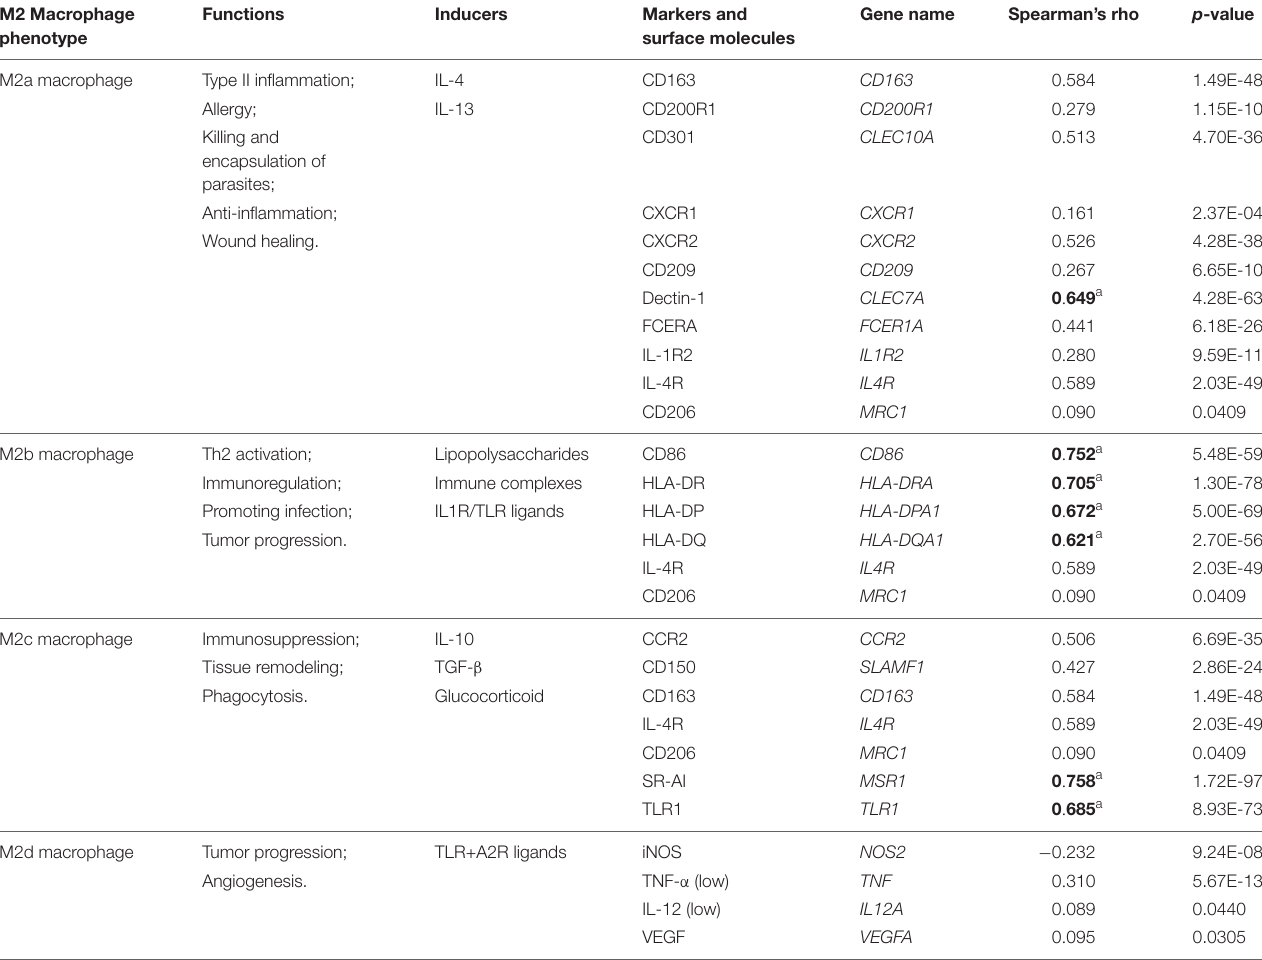
TABLE 2 | The correlations between HMOX1 and M2 macrophage phenotypes in LGG based on cell markers. M2 Macrophage